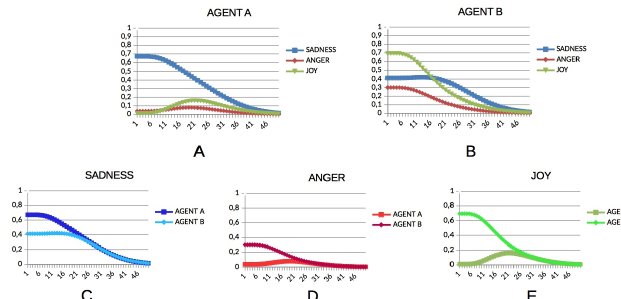
Fig. 6. Simulation results for amplification combined with absorption scenario set to downwards tendency, simulating three emotions SADNESS , ANGER and JOY : A) emotional dynamic of agent A , B) emotional dynamic of agent B , C) emotional dynamic of SADNESS on agents A and B , D) emotional dynamic of ANGER on agents A and B , and E) emotional dynamic of JOY on agents A and B . The horizontal axis denotes time elapsing in number of iterations and the vertical axis denotes emotional level. In this scenario, first emotions tend to meet each other in a sort of average, and then downwards spirals are